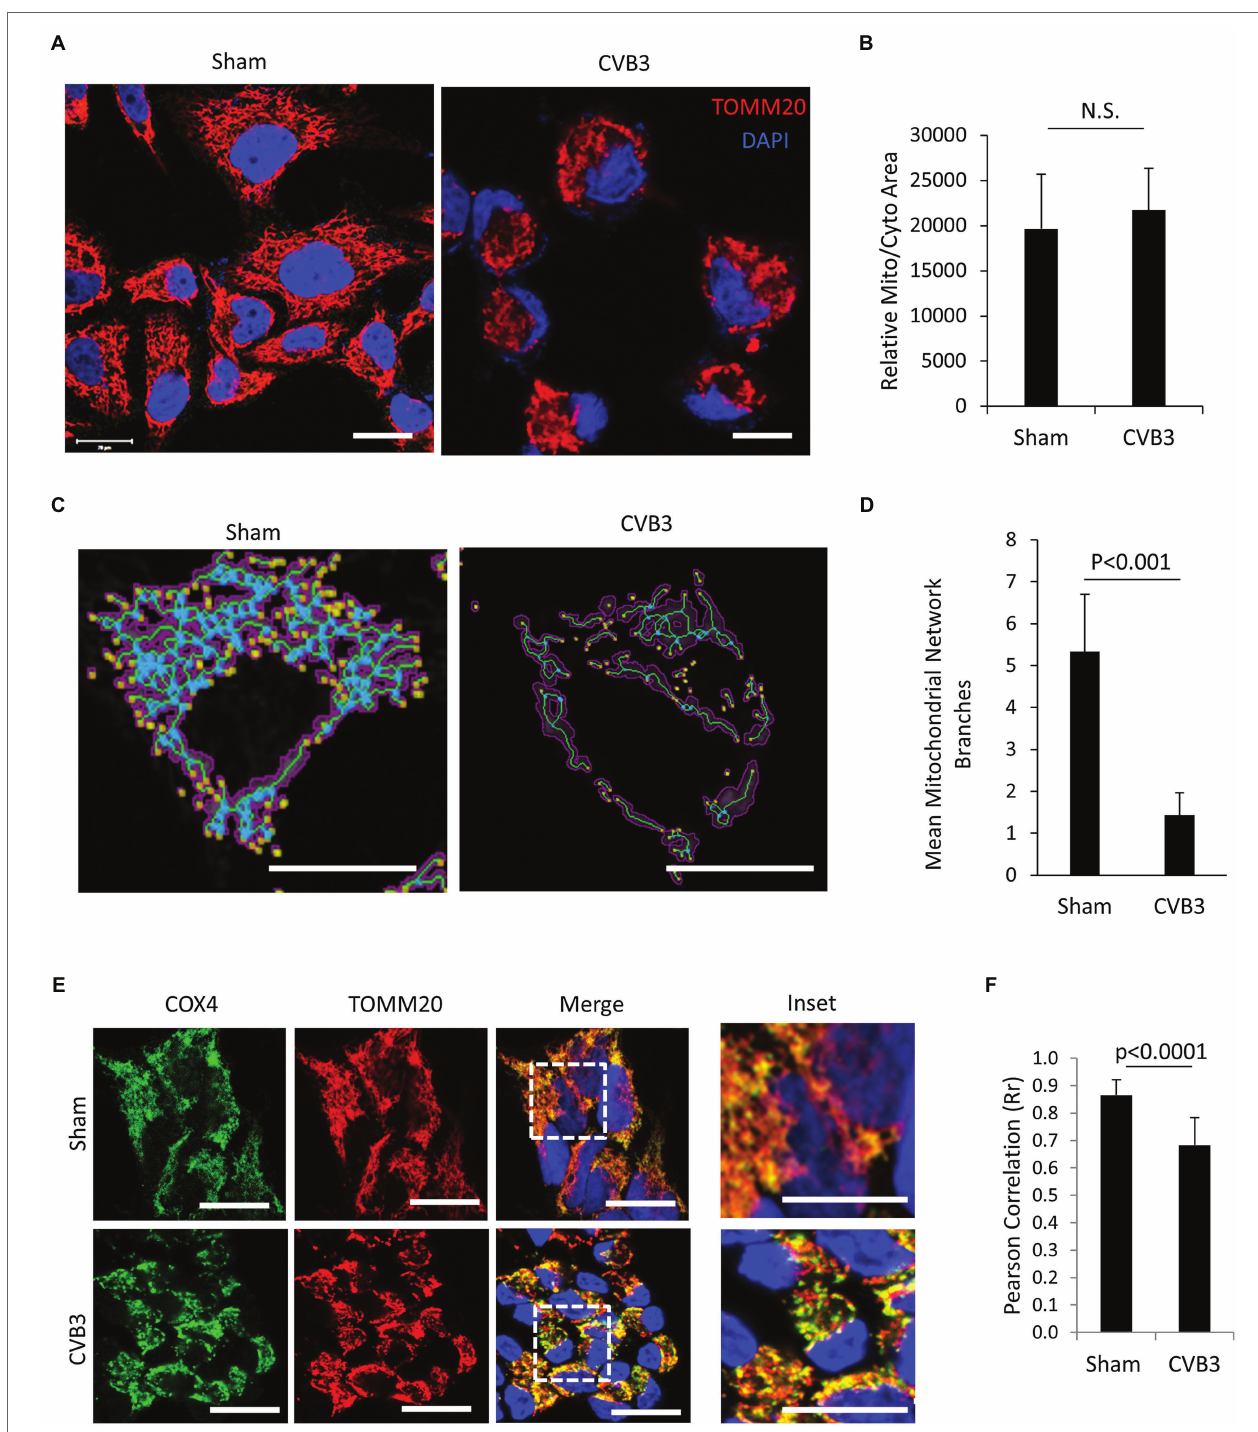
FIGURE 1 | CVB3 infection disrupts mitochondrial network. ( A and C ) HeLa cells were infected with CVB3 (MOI = 10, 5 h) or PBS (sham). Cells were fixed and immunostained with anti-TOMM20 (red) and counterstained with 4,6-diamidino-2-phenylindole (DAPI; blue). Mitochondrial network was analyzed using MiNA tool (C) . Magenta, binarized mitochondrial area; green, morphological skeleton; yellow, endpoints; and blue, junctions. Scale bar = 20 μ m. ( B and D ) Mitochondrial area normalized to total cellular area was measured using NIH ImageJ and presented as mean ± SD, n = 30 cells (B) . The mitochondrial network branches were quantified using the MiNA tool and presented as mean ± SD, n = 30 cells (D) . (E) HeLa cells were infected with CVB3 (MOI = 10, 5 h) or PBS (sham). Cells were fixed and immunostained with anti-COX4 (green) and anti-TOMM20 (red), followed by counterstain with DAPI (blue). Scale bar = 20 μ m. (F) Pearson’s correlation (Rr) of COX4 and TOMM20 following sham or CVB3 infection was quantified from (C) and presented as mean ± SD, n = 30